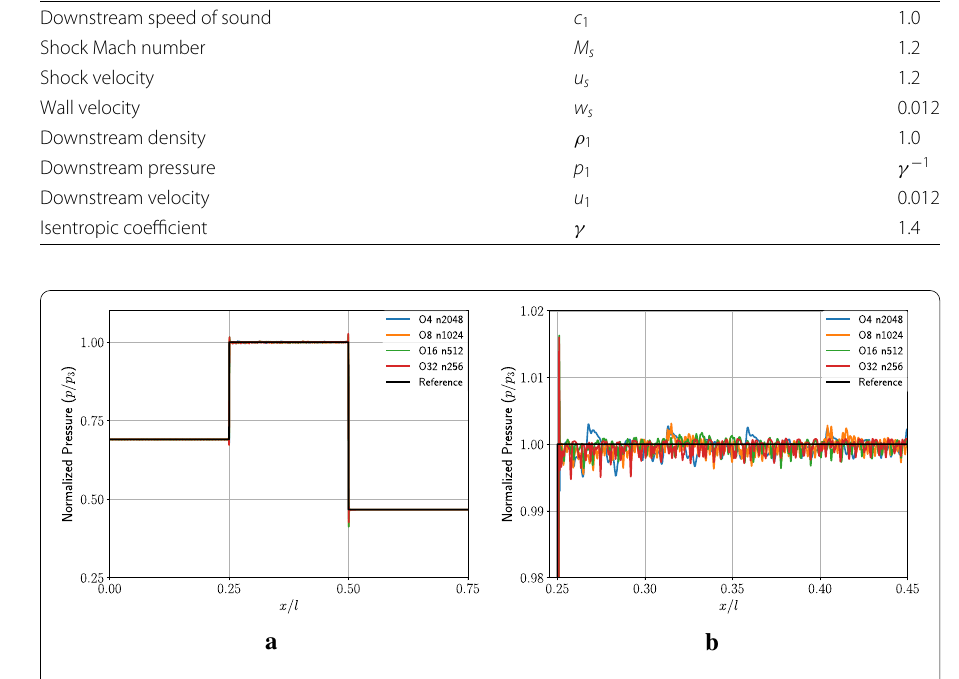
Fig. 8 Different curves represent different discretization for different scheme orders and number of elements. a Normalized pressure of the reflected shock wave. b Zoom of the reflected shock